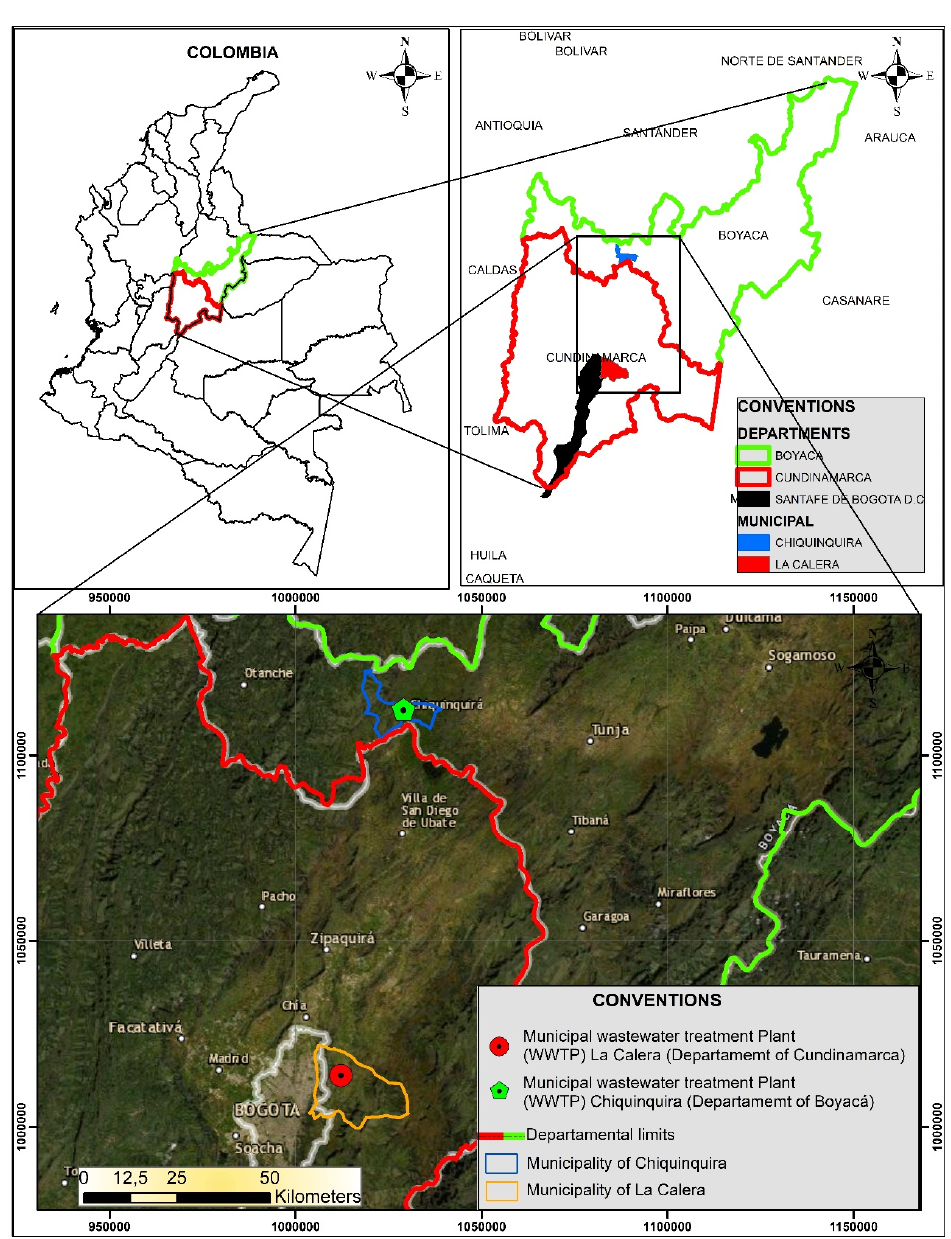
Figure 1. La Calera and Chiquinquirá, Colombia WWTPs localization. Table 1. Municipalities of La Calera and Chiquinquirá, Colombia WWTPs sludge treatment and condition description. WWTPs Flow